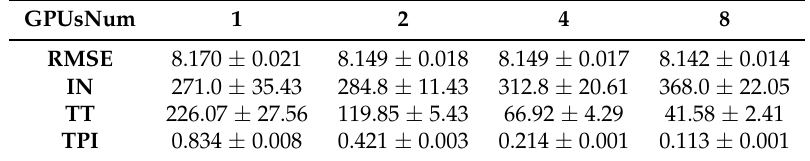
Table 11. Comparison of different GPUsNum in MG-ACOEE on the parallel performance for Urban